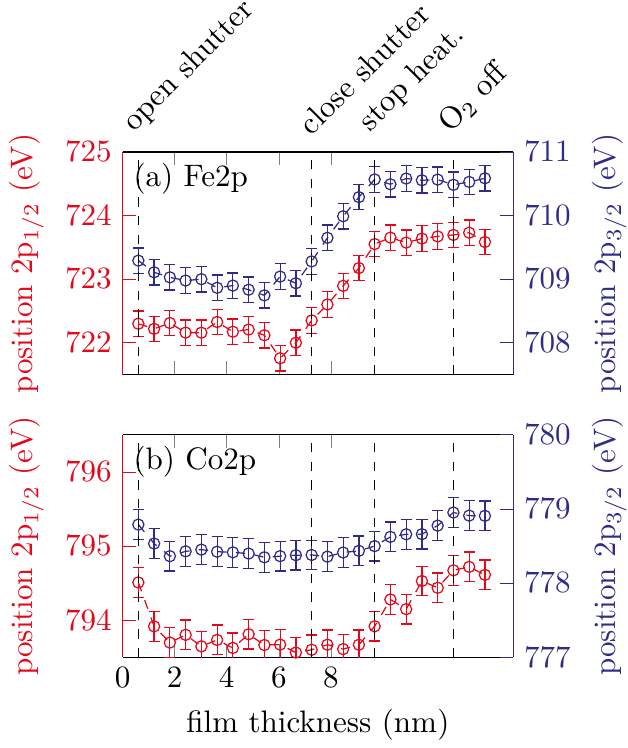
Figure 5. Peak positions of the ( a ) Fe 2p and ( b ) Co 2p peaks for sample B. It is clearly visible that both of the Fe 2p peak position remain constant for approxi- mately the first 7.26 nm until the shutter is closed and then shift to higher binding energies with increasing scans, which corresponds to an increasing amount of Fe 3 + valence states. After the heater is turned off, the peak positions remain constant at around ( 710.8 ± 0.4 ) eV for the Fe 2p and ( 723.7 ± 0.4 ) eV for the Fe 2p peak. The peak positions for both 3/2 1/2 the Co 2p and Co 2p peaks remain constant within uncertainties until the heater is 3/2 1/2 turned off, at around 778.5 eV and 793.7 eV, respectively. This indicates Co 2 + valence states. After the heater is turned off, the peak positions shifting to higher binding energies until the oxygen valve is closed.